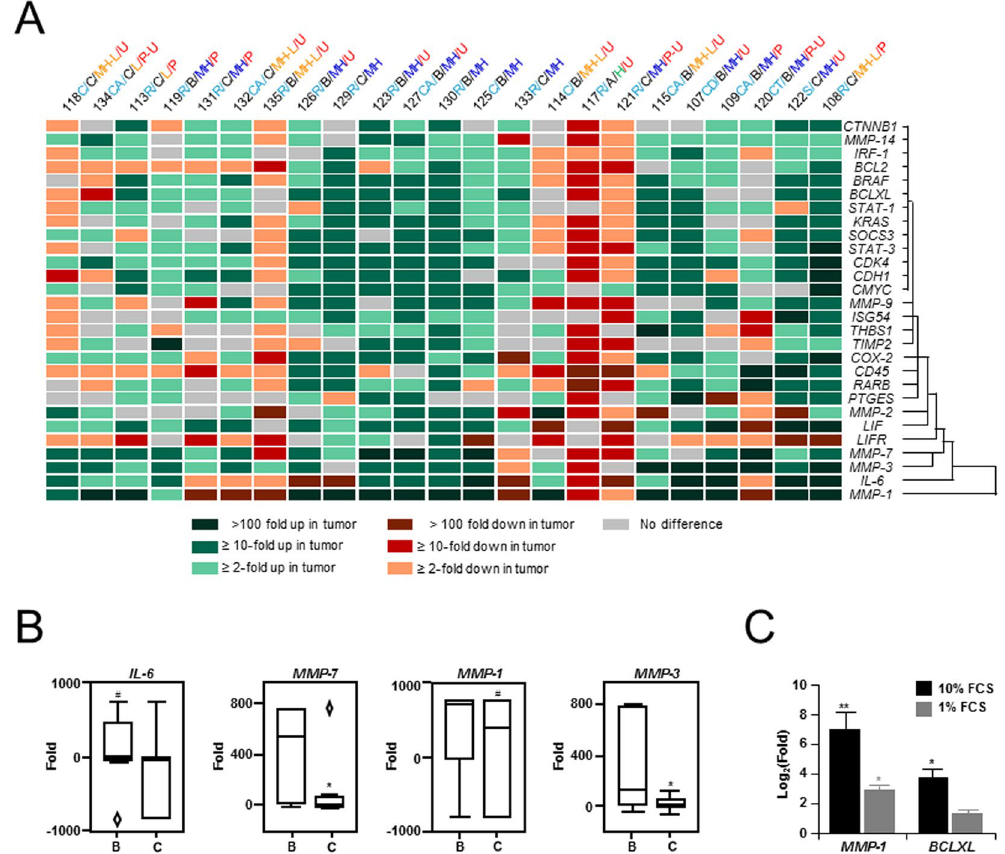
Figure 1. Comparative expression analysis. ( A ) Heat map showing relative fold differences in gene expression between tumor-tissue and patient matched normal mucosa. Clustering was based on nearest neighbor hierarchy analysis. Where expression was below the level of sensitivity for detection in either the normal mucosa or tumor, values were assigned numerically reflecting the upper and lower bounds of the data set (no expression in control, 800; no expression in tumor, − 800). Data was analyzed by Spearman’s ρ correlation analysis ( α = 0.05). Abbreviations for anatomical location: Cecum [C]; Colon Ascending [CA]; Colon Transverse [CT]; Colon Descending [CD]; and Sigmoid Colon [S]; for Dukes’ staging [B & C]; for differentiation: Low [L]; Medium High to Low [MH-L]; Medium High [MH]; and High [H]; for ulceration: Ulcerous [U]; Polypous [P]; Mixed Polypous-Ulcerous [P-U]. ( B ) Results of Q-PCR analysis showing differences in mRNA levels for MMP- 1 , MMP-3 , MMP-7 and IL-6 between Dukes’ B and Dukes’ C tumors. Data is represented as box plots with median (thick line), first and third quartiles (boxed), upper and lower values (whiskers) and outliers ( ◊ ), and was analyzed by Mann Whitney U ( α = 0.05, * P < 0.05). ( C ) Results of Q-PCR analysis following IL-6 treatment of SW480 colorectal cancer cells, showing significant up-regulation of MMP-1 mRNA. Notably, induction was enhanced under high (10%) serum conditions ( Left ), compared with low serum (1%) ( Right ). Similar results were obtained in other cell lines, including LS174T ( not shown ). Also shown, the effects of IL-6 on the known IL-6 target gene, BCLXL . Similar results were obtained for BCL-2 and STAT-3 (not shown) . Each experiment was repeated showing similar results, and data represented as mean Log 2 (Fold) ± SEM, and was analyzed by Independent t test ( α = 0.05, ** P <